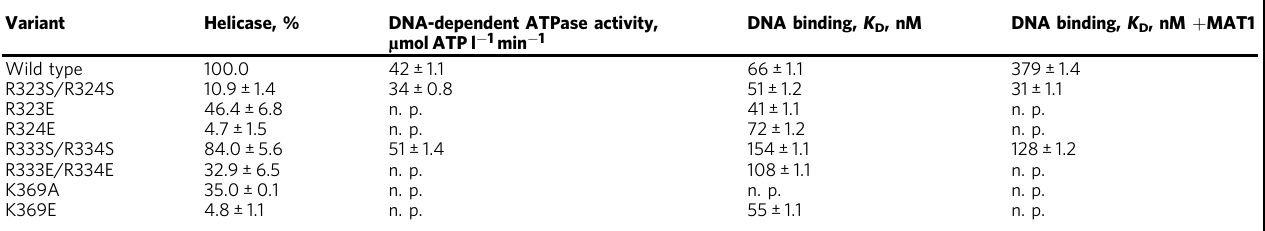
Table 1 Kinetic parameters of ctXPD